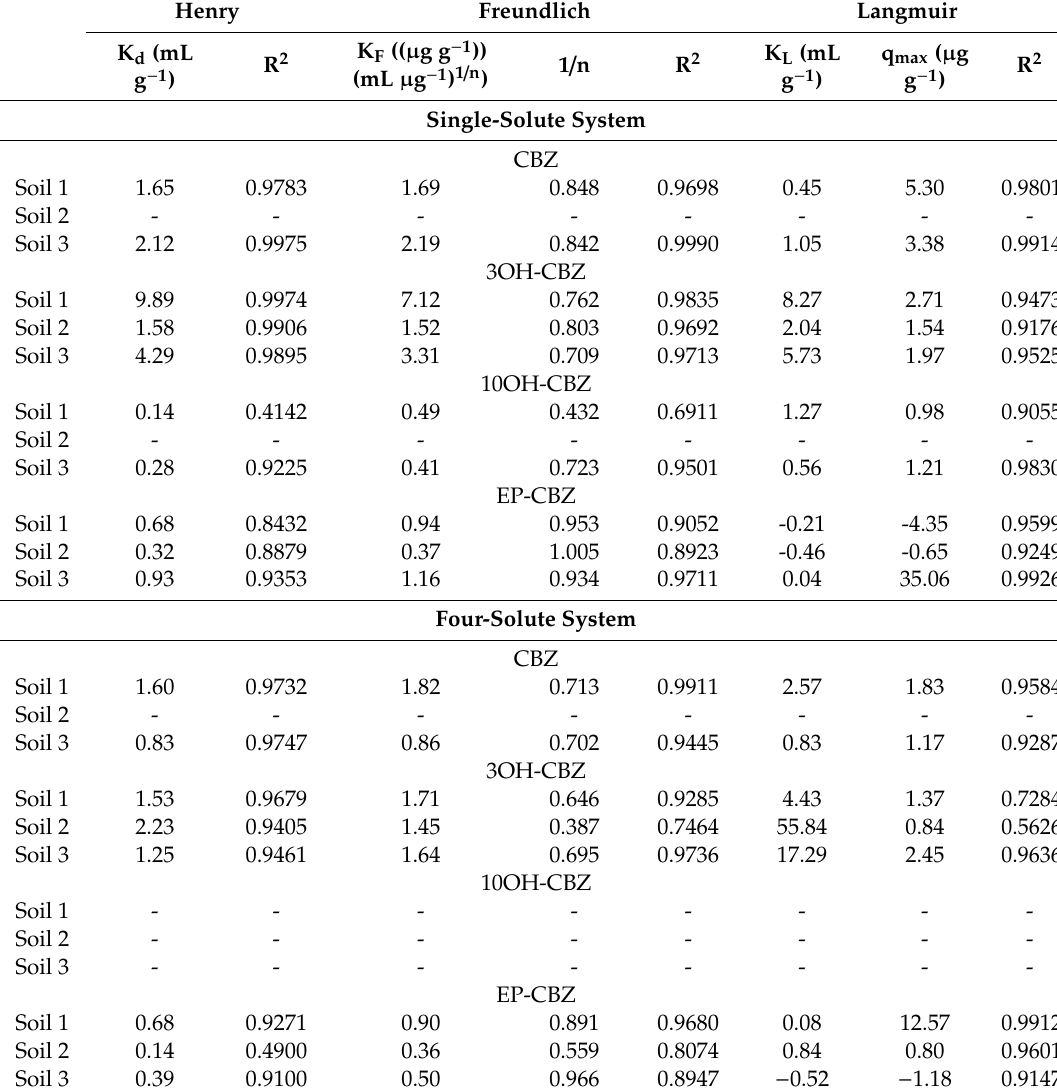
Table 1. Soil / water partition coe ffi cient (K d ), Freundlich constant (K F ), Freundlich exponent (1 / n), Langmuir constant (K L ), and maximal sorption capacity (q max ) of CBZ and its metabolites measured in the studied